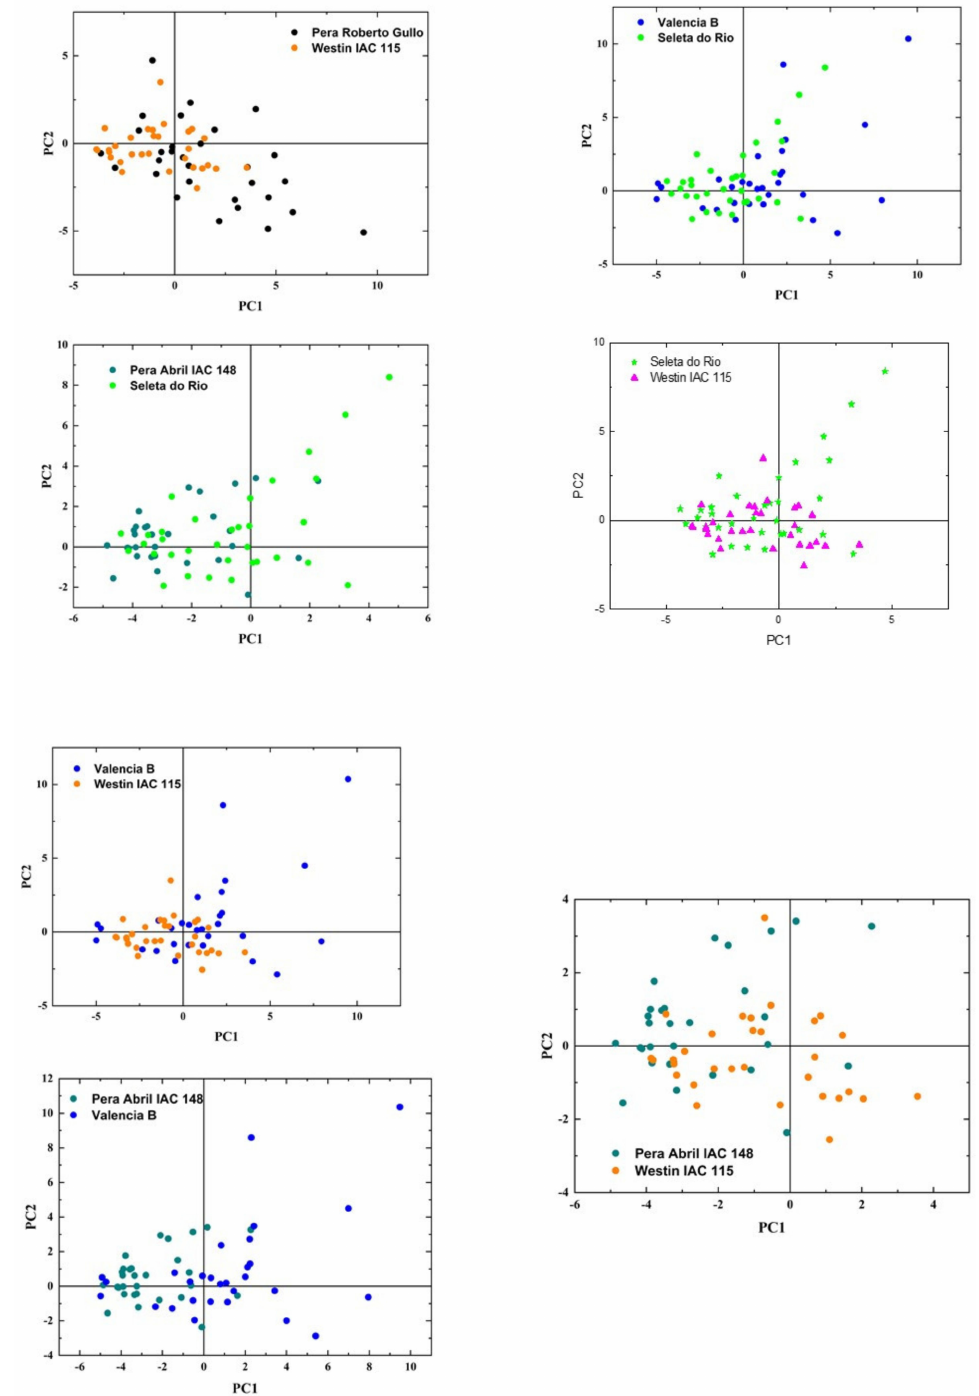
Figure 6. PCA 2-dimensional loading plots of PC2 versus PC1 compared by pair for Valencia B, Pera Abril IAC 148, and Westin IAC 115 accessions of the Common variety of set